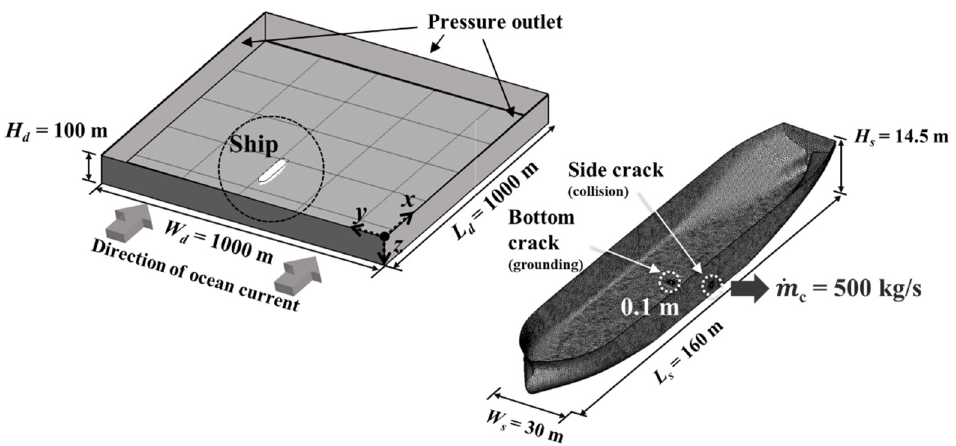
Figure 1. The schematic of the representative current profile.